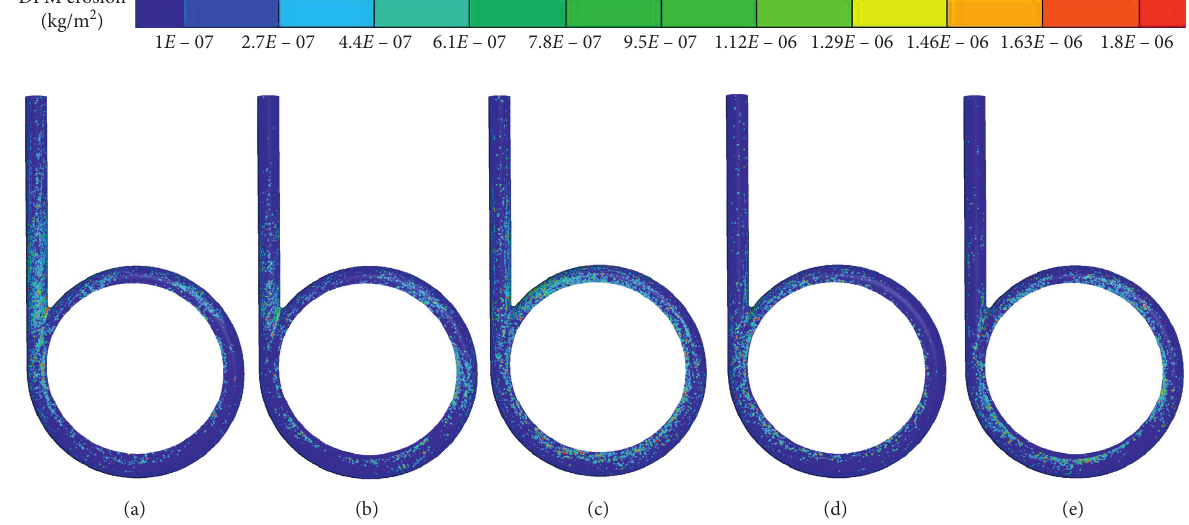
Figure 16: Volute wear clouds at different particle volume concentrations. (a) C � 10%, (b) C � 15%, (c) C � 20%, (d) C � 25%, and (e) C �